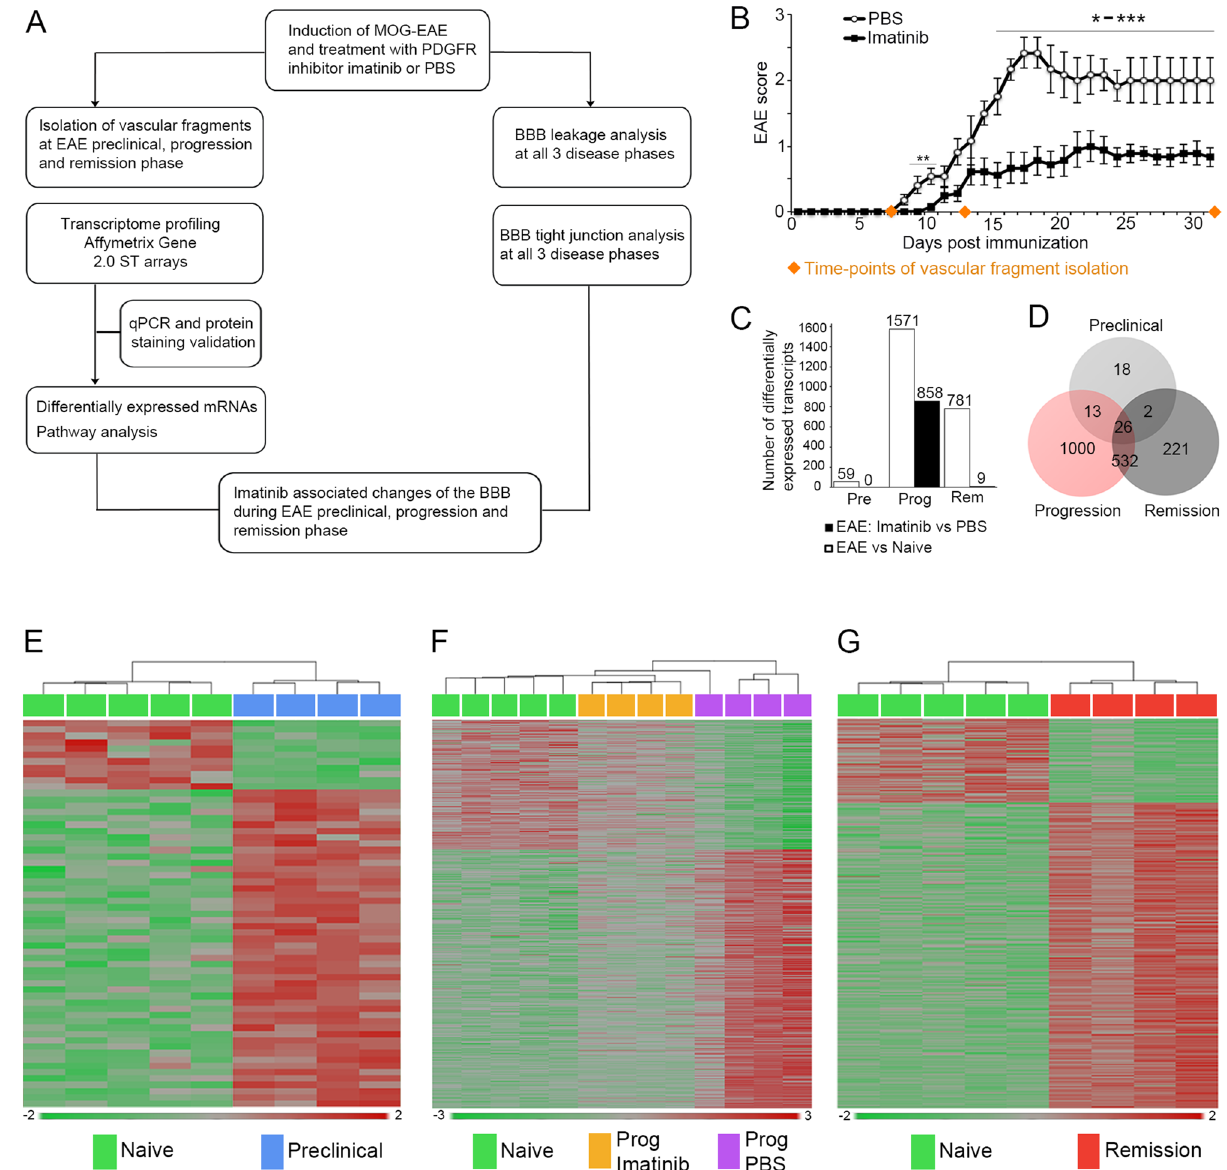
Figure 1. Transcriptome analysis of spinal cord endothelial cell enriched vascular fragments during the preclinical, progression and remission phase of EAE. ( A ) Schematic illustration of study design: C57BL/6N mice were immunized with MOG to induce EAE and treated either with the PDGFRα inhibitor imatinib or PBS from day 2 p.i. until the end of the experiment. At the preclinical, progression and remission phase, spinal cords were harvested and vascular fragments were isolated (n = 4 mice for each disease phase and treatment group, respectively). In addition, vascular fragments from healthy naive (non-immunized) mice were isolated (n = 5). RNA prepared from vascular fragments was hybridized to Affymetrix mouse Gene 2.0 ST arrays and differential gene expression was confirmed with qPCR. Analysis of BBB leakage and tight junctions was done on spinal cord cross-sections. ( B ) EAE induced mice treated with imatinib showed significantly decreased clinical scores compared to PBS treated mice (n = 6 for PBS and n = 9 for imatinib treated mice; 1 representative of 2 independent experiments is shown). ( C ) Representation of number of differentially expressed genes in the BBB transcriptome between naive and EAE induced mice (white bars: 59 at the preclinical phase, 1571 at the progression phase and 781 at the remission phase), and between imatinib and PBS treated EAE mice (black bars: 0 at the preclinical phase, 858 at the progression phase and 9 at the remission phase), respectively. ( D ) Venn diagram showing the distribution of differentially expressed transcripts between naïve and EAE induced mice. 26 transcripts were shared between all three disease phases, 13 between preclinical and progression phases and 532 between progression and remission phases. ( E – G ) Heat map diagrams showing differential expression profiles between naïve and EAE induced mice at preclinical ( E ), progression ( F ), and remission ( G ) phases, as well as between imatinib and PBS treated mice during EAE progression ( F ). Adjusted P value < 0.05 and a log2 fold change >1 was used as statistical cut off for all analyses. EAE scores are depicted as mean ± SEM. Statistical evaluation for EAE scores was performed using Mann–Whitney (* P < 0.05, ** P < 0.01, *** P < 0.001 and **** P < 0.0001). Abbreviations: